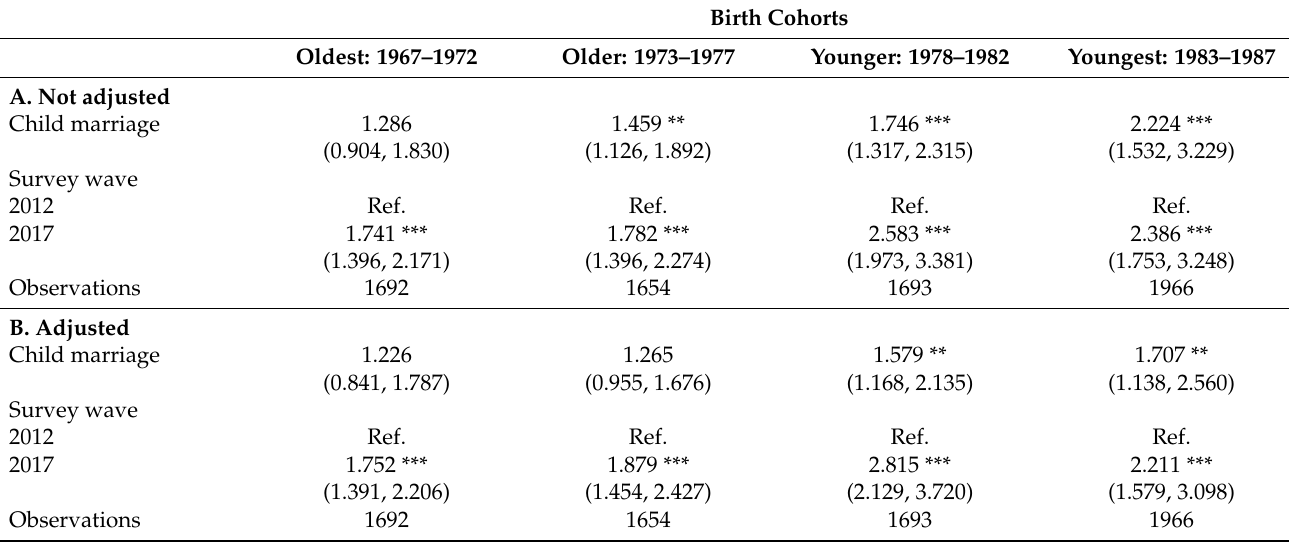
Table 4. Odds ratios in favor being obese by birth cohort.